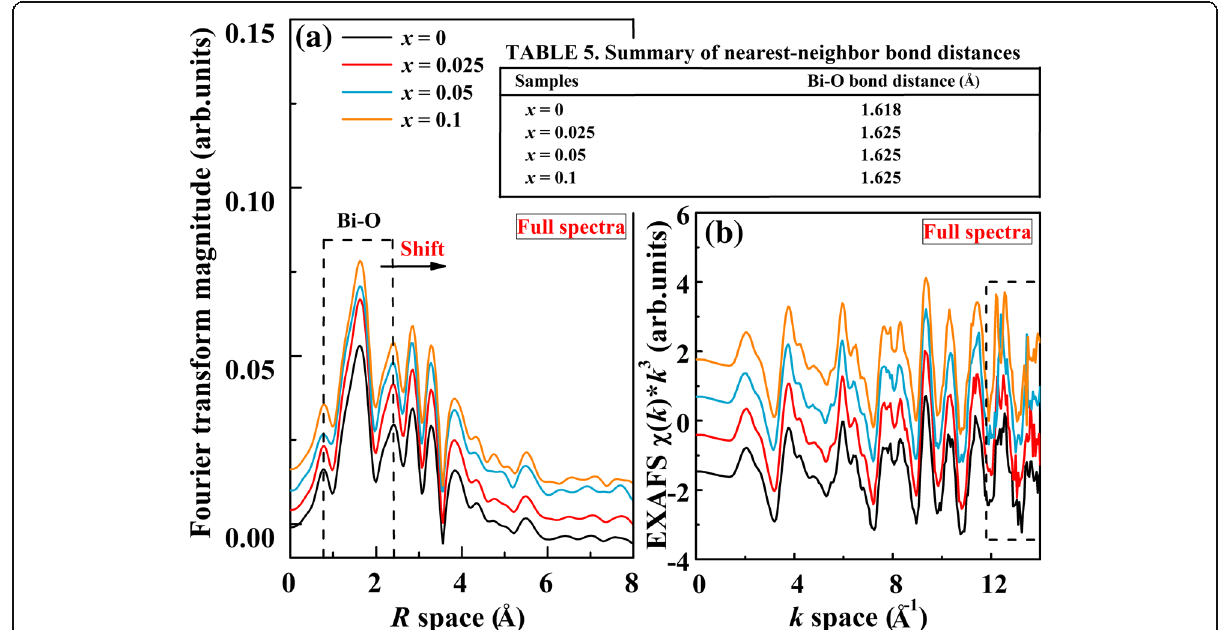
Fig. 6 a Fourier transforms of Bi L 3 -edge k 3 -weighted EXAFS data, for the BFA x O (0 ≤ x ≤ 0.1). b EXAFS χ ( k ) × k 3 spectra of BFA x O (0 ≤ x ≤ 0.1). The spectra were aligned along the Y